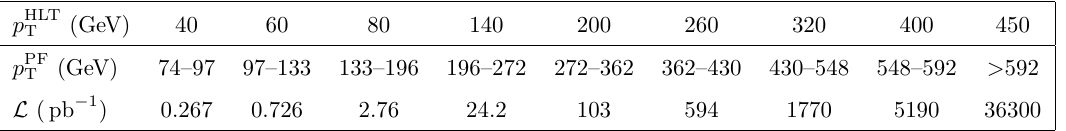
threshold for the HLT (offline PF) T